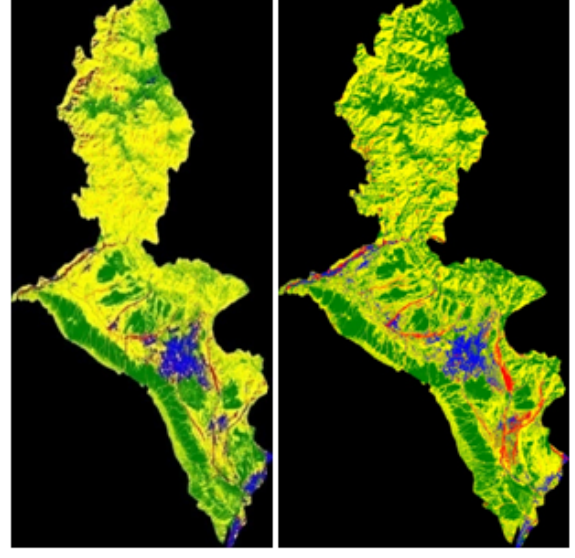
Figure 4: Collection of output Data generated by Sentinel-2 and LANDSAT-8 at resolution 30m by Random